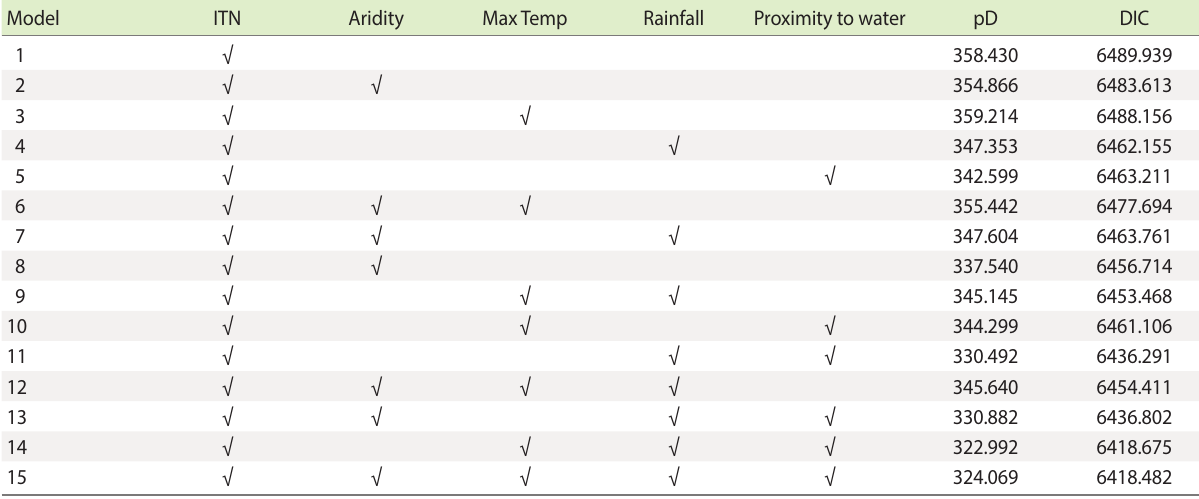
Table 4. pD and DIC of 15 partial pairwise spatial generalized linear model Model